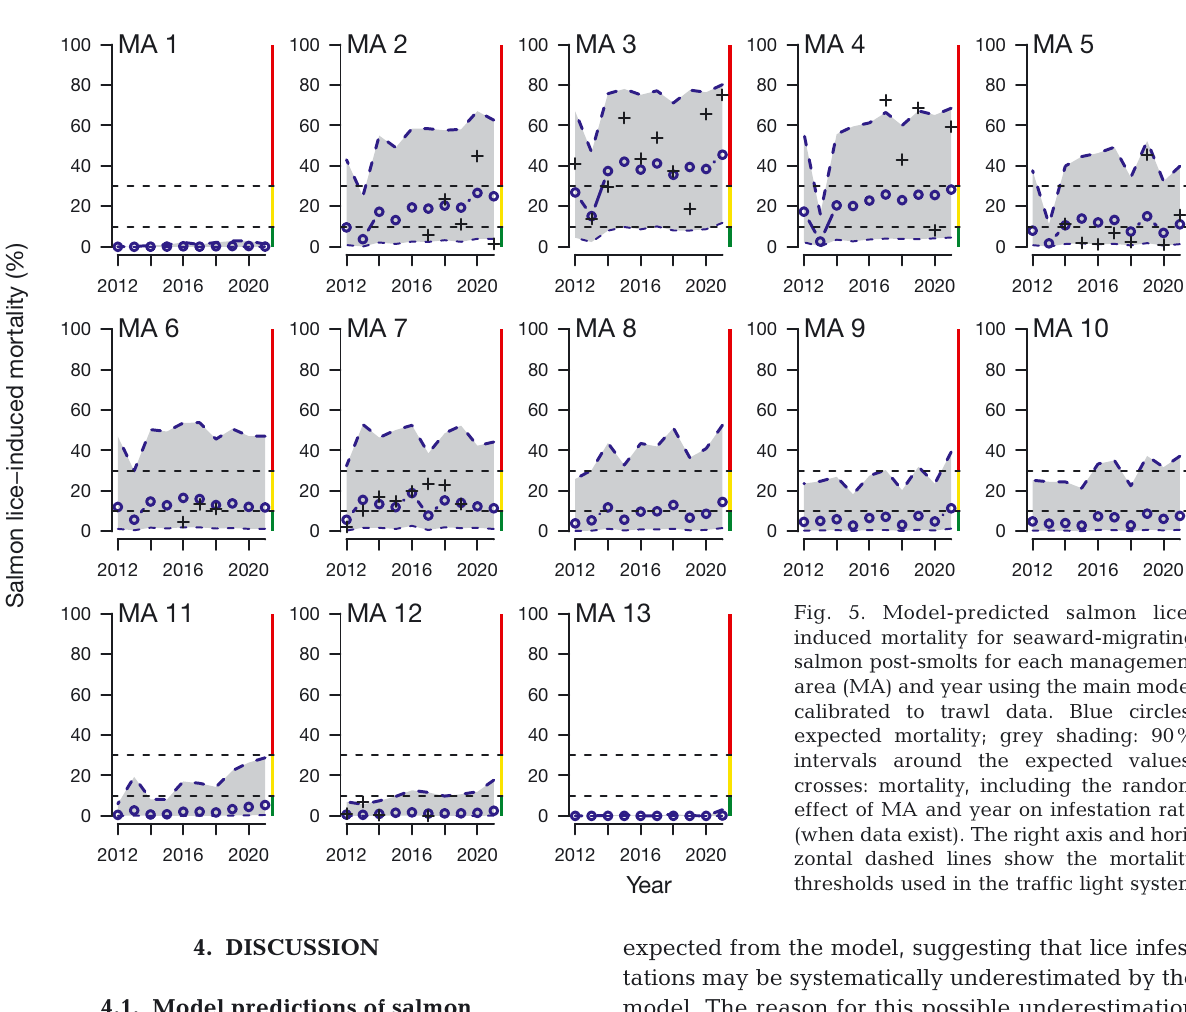
Fig. 5. Model-predicted salmon lice- induced mortality for seaward-migrating salmon post-smolts for each management area (MA) and year using the main model calibrated to trawl data. Blue circles: expected mortality; grey shading: 90% intervals around the expected values; crosses: mortality, including the random effect of MA and year on infestation rate (when data exist). The right axis and hori- zontal dashed lines show the mortality thresholds used in the traffic light